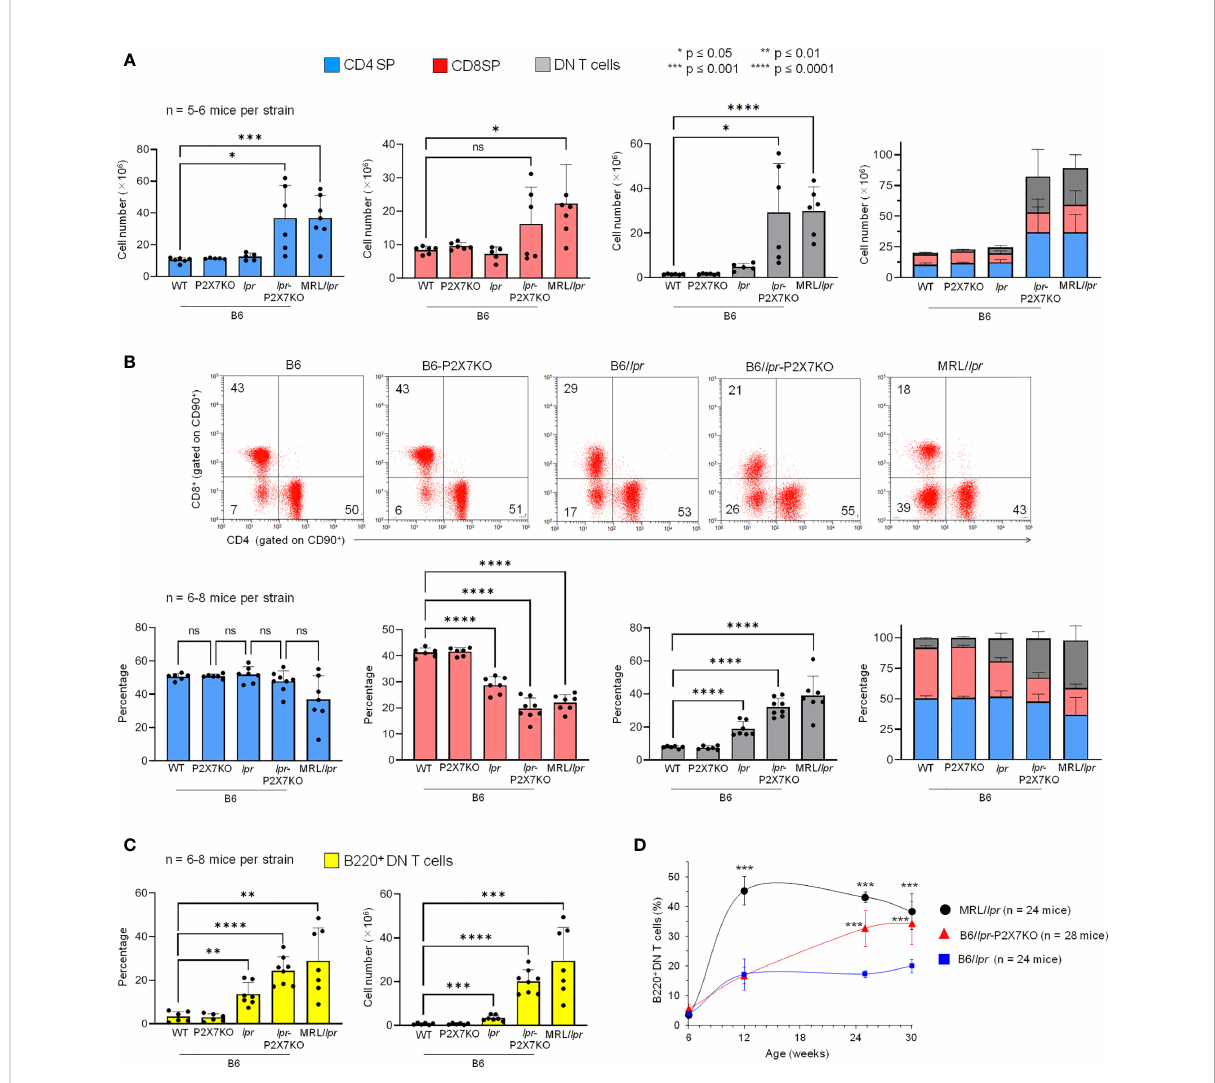
FIGURE 2 Quanti fi cation of the percentage and absolute number of SP, DN, and B220 + DN T cells and level of CD4 and CD8 on SP T cells in B6 /lpr- p2x7 KO mice and parental strains. Spleen cells from 7- to 8-month-old female B6, B6- p2x7 KO, B6/ lpr and B6/ lpr - p2x7 KO mice and 4-month- old female MRL/ lpr mice were stained with either fl uorescent mAbs against the phenotypic markers CD90, B220, CD4, and CD8 or isotype controls and analyzed by fl ow cytometry. Bar graphs show the absolute number (A) and percentage (B) of CD4 SP ( ), CD8 SP ( ) and DN ( ) T cells among CD90 + T cells from each mouse strain. Data are expressed as mean (SD) of 5-8 mice per strain and each dot in the bar graphs represents an individual mouse. Stacked bar graphs (A, B) show the respective proportions of SP and DN CD90 + T cells in each mouse strain. Error bars in graphs show SD. (B) Representative fl ow cytometry plots of CD4 and CD8 expression in gated CD90 + T cells. (C) Bar graphs show the percentage and absolute number of B220 + DN CD90 + T cells from each mouse strain. Data are expressed as mean (SD) of 6-8 mice per strain. (D) Kinetics of B220 + DN CD90 + T cell accumulation in LNs of B6/ lpr ( ), B6/ lpr - p2x7 KO ( ), and MRL/ lpr ( ) mice measured by fl ow cytometry. Data are expressed as mean (SD) of 6-7 mice per time point. Error bars in graphs show SD. Asterisks above horizontal lines indicate statistically signi fi cant differences assessed with unpaired two-tailed t -test. *p ≤ 0.05, **p ≤ 0.01, ***p ≤ 0.001, ****p ≤ 0.0001 and ns, not signi fi